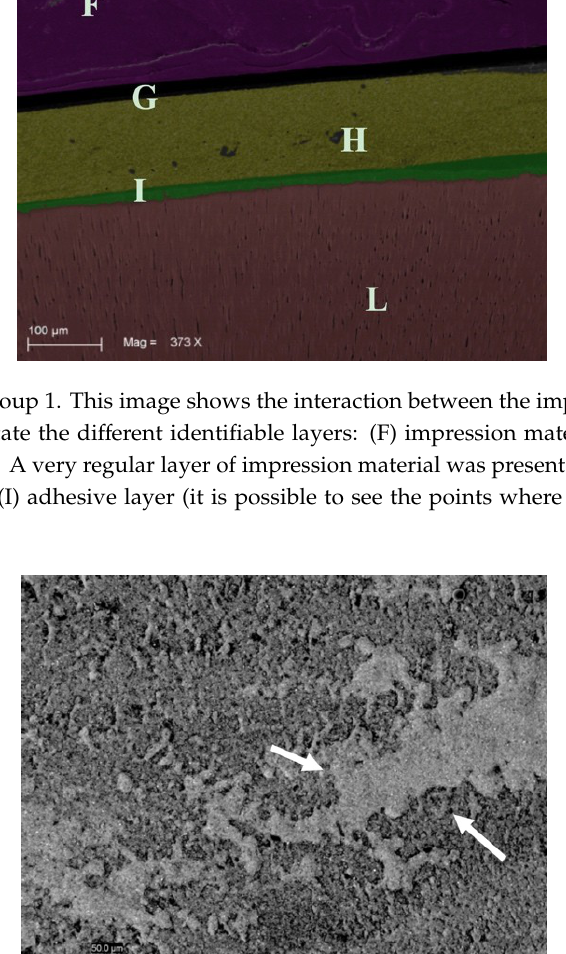
Figure 4. This image (Group 1) shows the interaction between the impression material and the OIL.